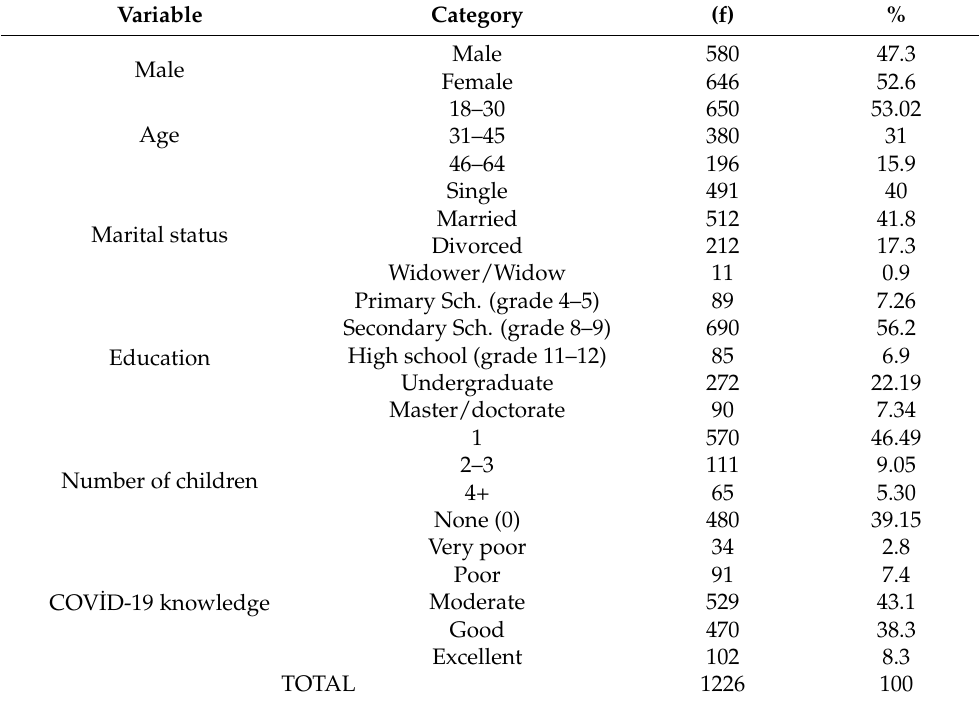
Table 1. Basic socioeconomic and demographic information of respondents ( n =